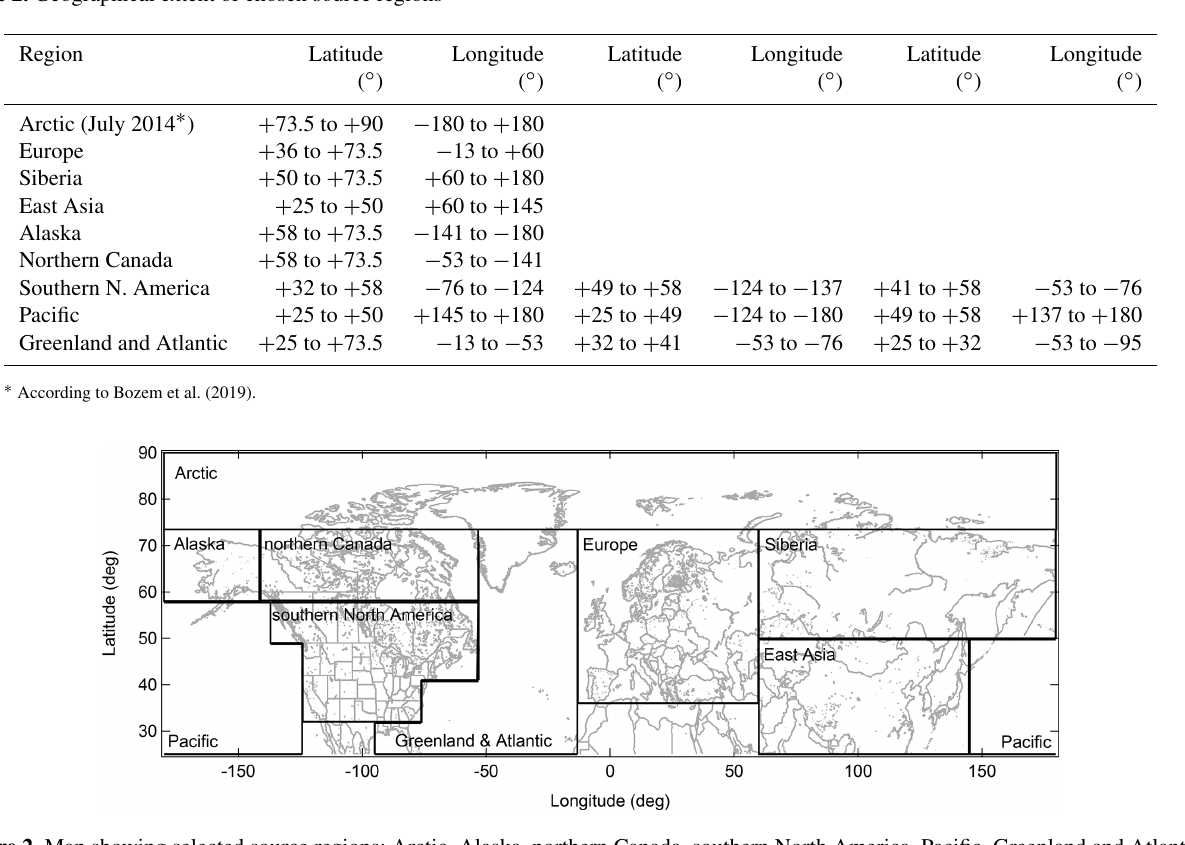
Figure 2. Map showing selected source regions: Arctic, Alaska, northern Canada, southern North America, Pacific, Greenland and Atlantic, Europe, Siberia, and East